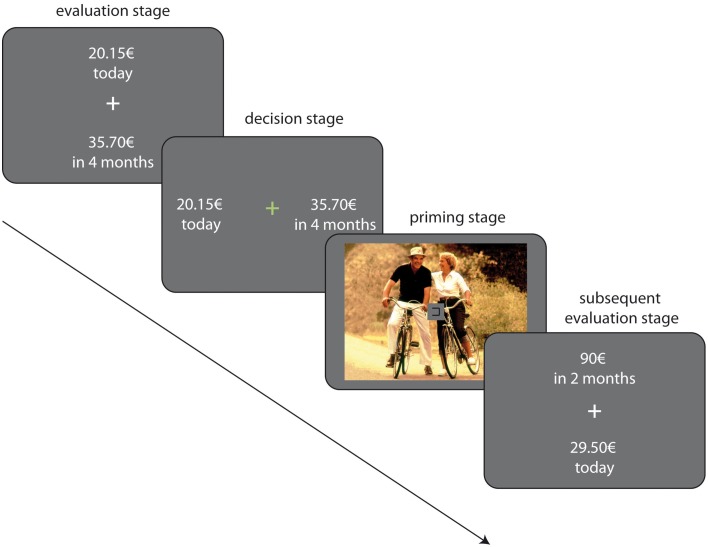
Illustration of the experimental paradigm.